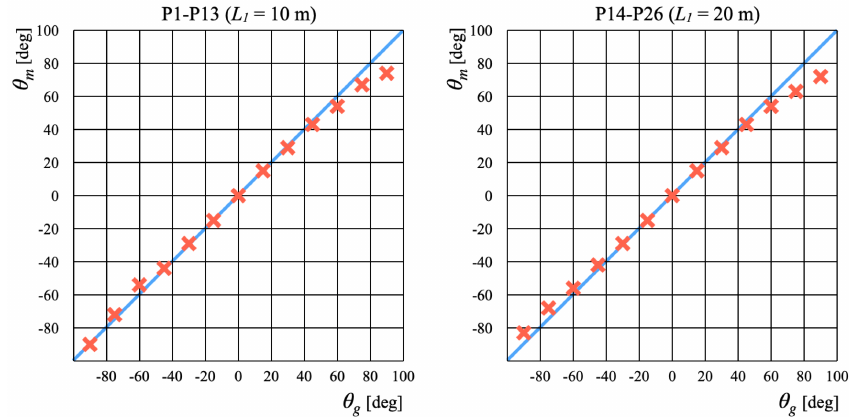
Figure 10. Scatter plots of θ g and θ m for P1–13 ( left ) and P14–26 ( right ).